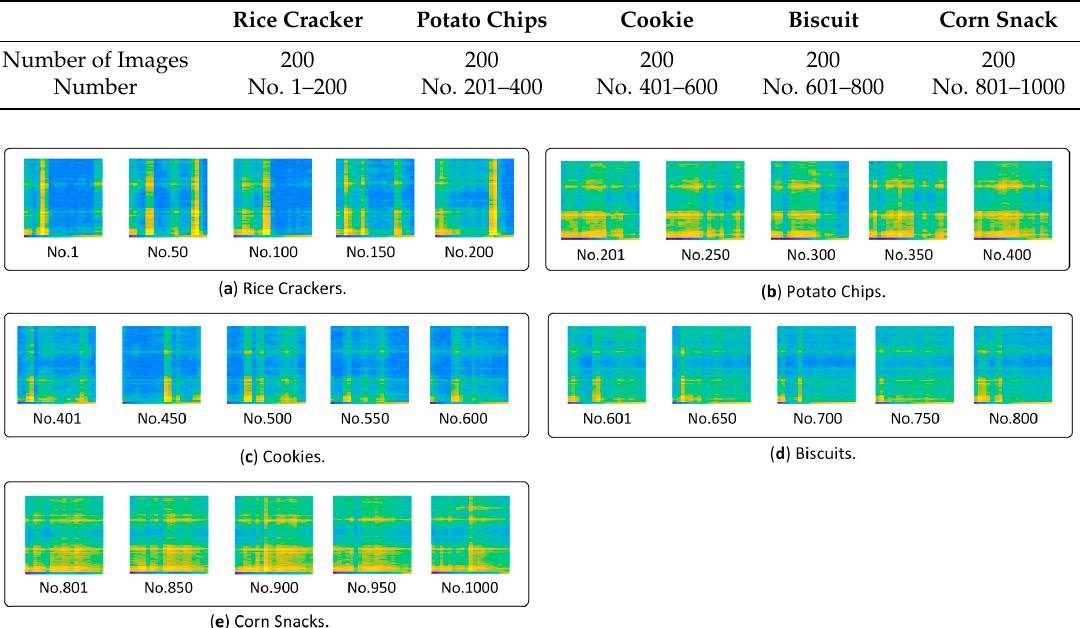
Figure 17. Images inputted to CNN: ( a ) Rice crackers; ( b ) potato chips; ( c ) cookies; ( d ) biscuits and; ( e ) corn snacks.